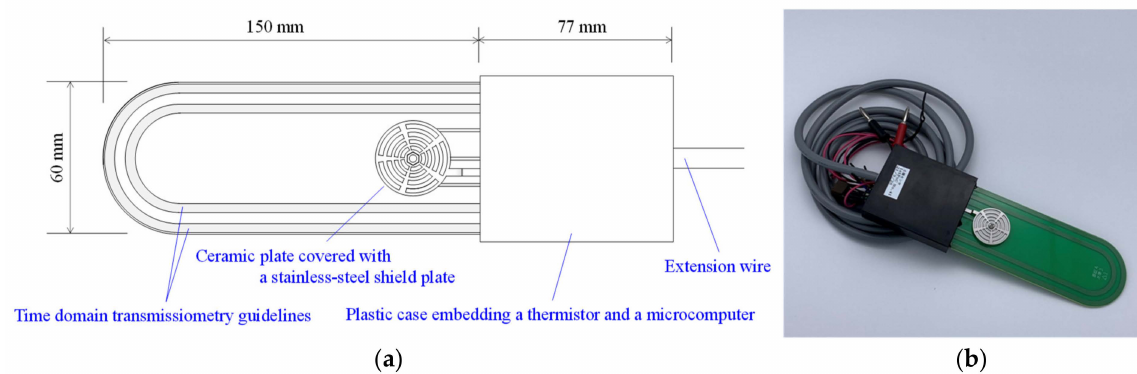
Figure 1. ( a ) Schematic and ( b ) photograph of the proposed sensor.